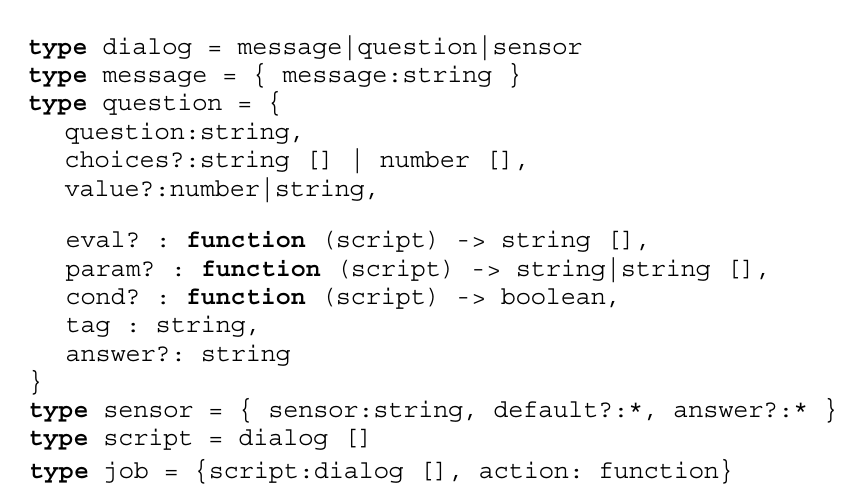
19 of 38 Figure 9. ( Bottom ) Chat dialogue of the JAM App showing messages and questions from chat bot agents and principle mediator agent behaviour scheduling the user chat ( Top ). The following Definition 1 describes the dialogue script passed to a chat bot agent that is used to perform the crowd sensing on mobile devices by the chat bot agents. The question dialogue is dynamic: (1) Some questions are only presented based on answers of previous questions → cond function, and (2) some question texts are updated based on previous answers → eval function replacing text variables $ in the question text with values returned by an array. The optional